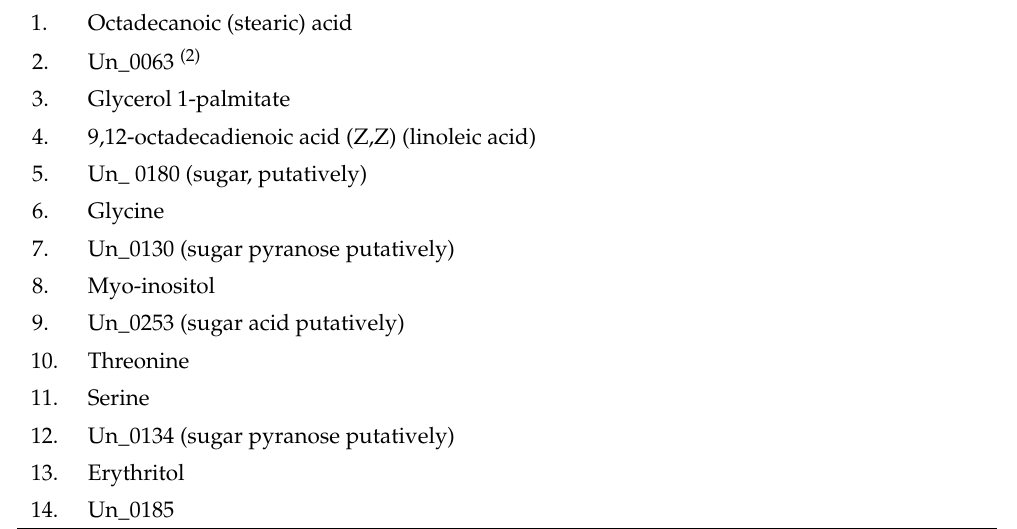
Table 3. The blood plasma metabolites identified with significantly lower abundances in the most glucocorticoid-sensitive (S) compared to the most glucocorticoid-resistant (R) healthy subjects based on the multivariate significance analysis SAM method, as implemented in the TM4/MeV software. The metabolites are shown in decreasing significance based on the SAM curve shown in Figure S2. Negatively Significant Metabolites in the S vs. the R Group in Decreasing Significance